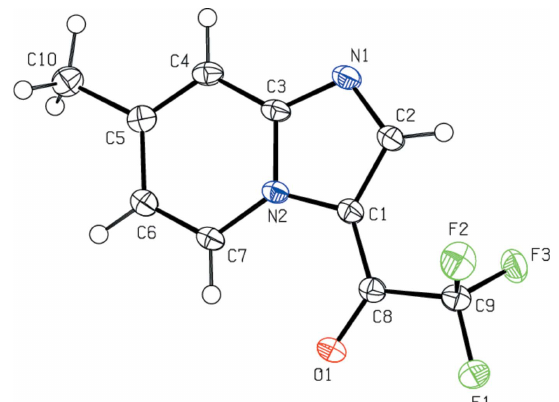
Figure 1 Molecular structure of the title compound showing the atom labelling and displacement ellipsoids drawn at the 50% probability level.